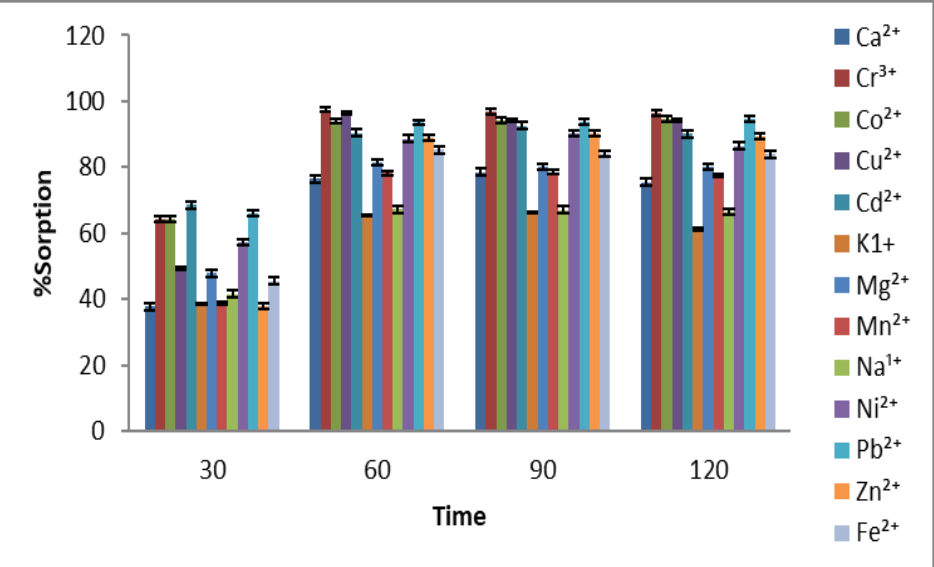
Figure 2. Effect of contact time (30 – 120 min) on % adsorption of 13 selected metal ions using Aerva javanica as the sorbent.